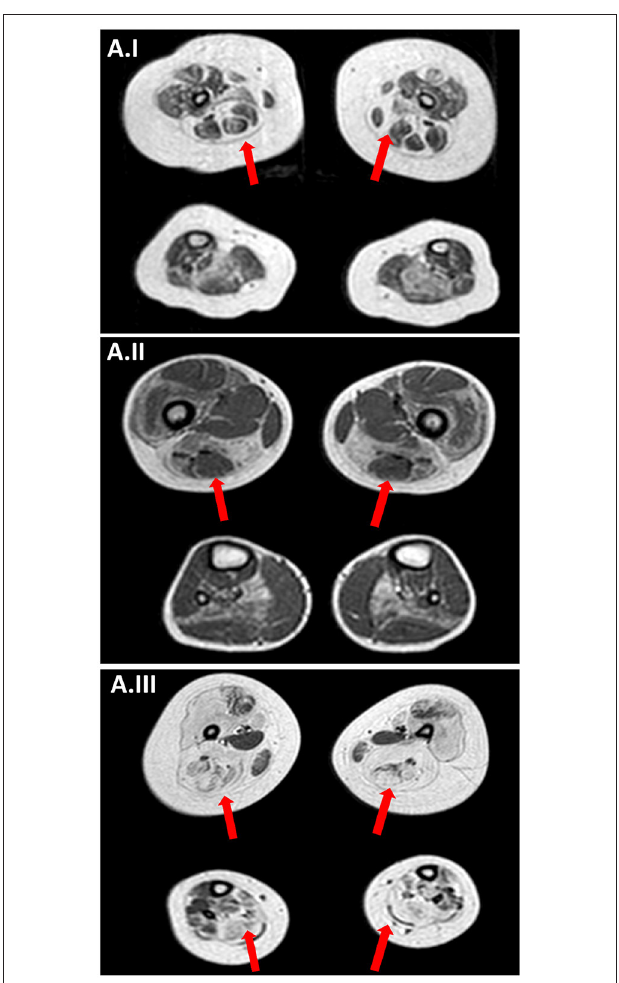
FIGURE 3 | Muscle MRI. (A.I) Muscle MRI (Patient II; 18-months old) axial TSE T1 images at thigh and lower leg level showing a bilateral and symmetrical atrophy and fatty infiltration of gluteus maximus, sartorius, adductor magnum and, at lower leg level, in soleus muscle a pattern compatible with RYR1 -RCM. (A.II) Muscle MRI (Patient III.1; 5 years old) axial TSE T1 images at thigh and lower leg level showing a bilateral and symmetrical atrophy and fatty infiltration of vastus lateralis, sartorius, adductor magnum and, at lower leg level, in soleus muscle a pattern compatible with RYR1 -RCM. (A.III) Muscle MRI (Patient III.2; 7 years old) axial TSE T1 images showing bilaterally muscle atrophy with diffuse fat substitution of pelvic girdle muscles thigh and lower